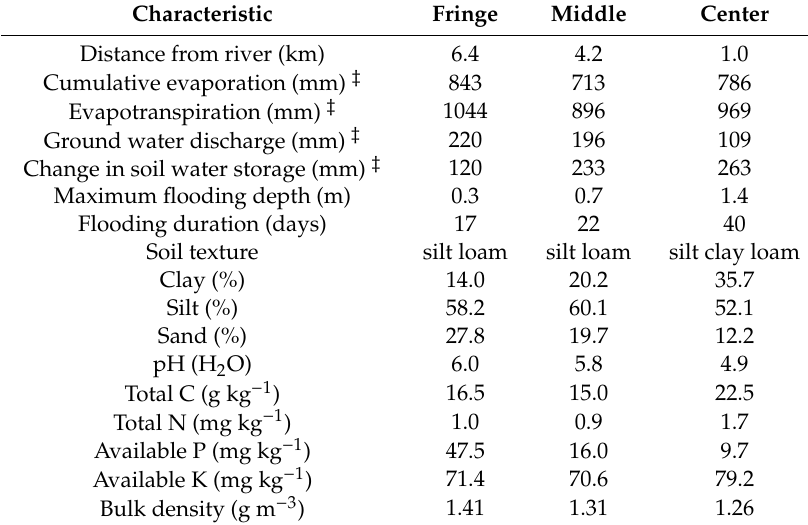
Table 1. Selected characteristics of the di ff erent experimental sites and top soils (0–20 cm) in the Kilombero